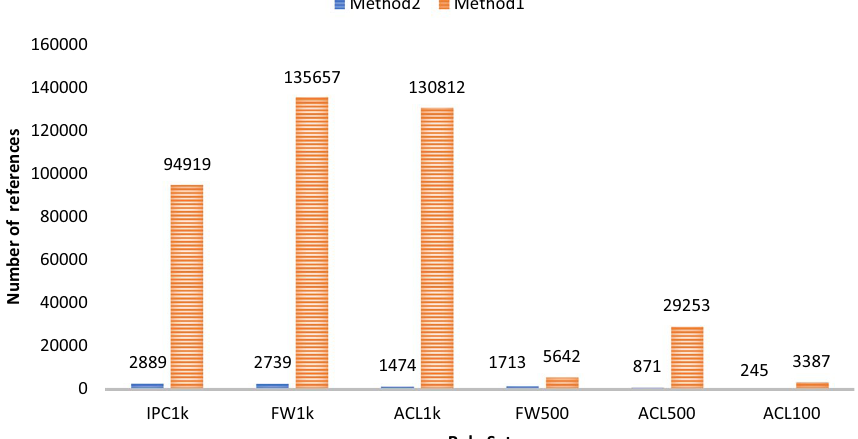
Fig. 14 Number of references for adding a new rule